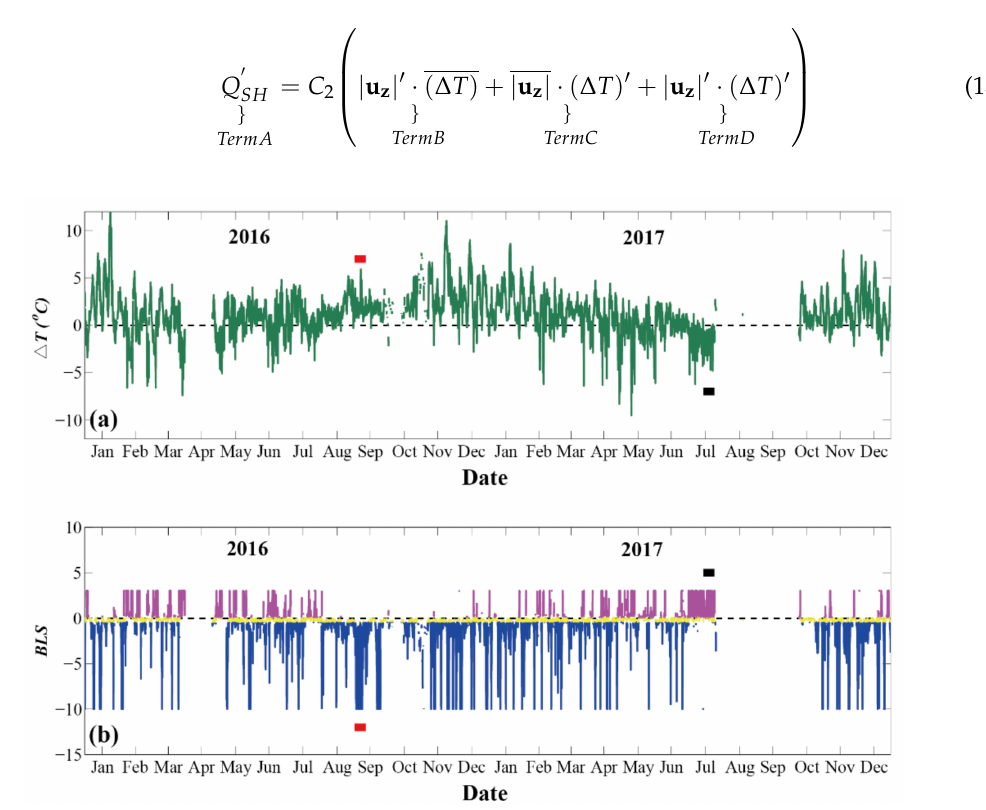
Figure 16. ( a ). The hourly air-sea temperature differences ( ∆ T ) from January 2016 to December 2017. ( b ). The hourly boundary layer stability (BLS) associated with the Monin–Obukhov stability parameter ξ = z / L . Note that the stable boundary conditions ( ξ > 0.1) are plotted in magenta, while the unstable ( ξ < − 0.4) and near-neutral ( − 0.4 < ξ < 0.1) boundary conditions are plotted in blue and yellow, respectively. The ξ smaller than − 10 are set to − 10 for visual examination. The hourly ten-day unstable BLSs (blue) and positive air-sea temperature differences are marked by red bars from September 2 to 11 September in 2016, while the stable BLCs (magenta) and negative air-sea temperature differences are marked by black bars from 16 July to 25 July in